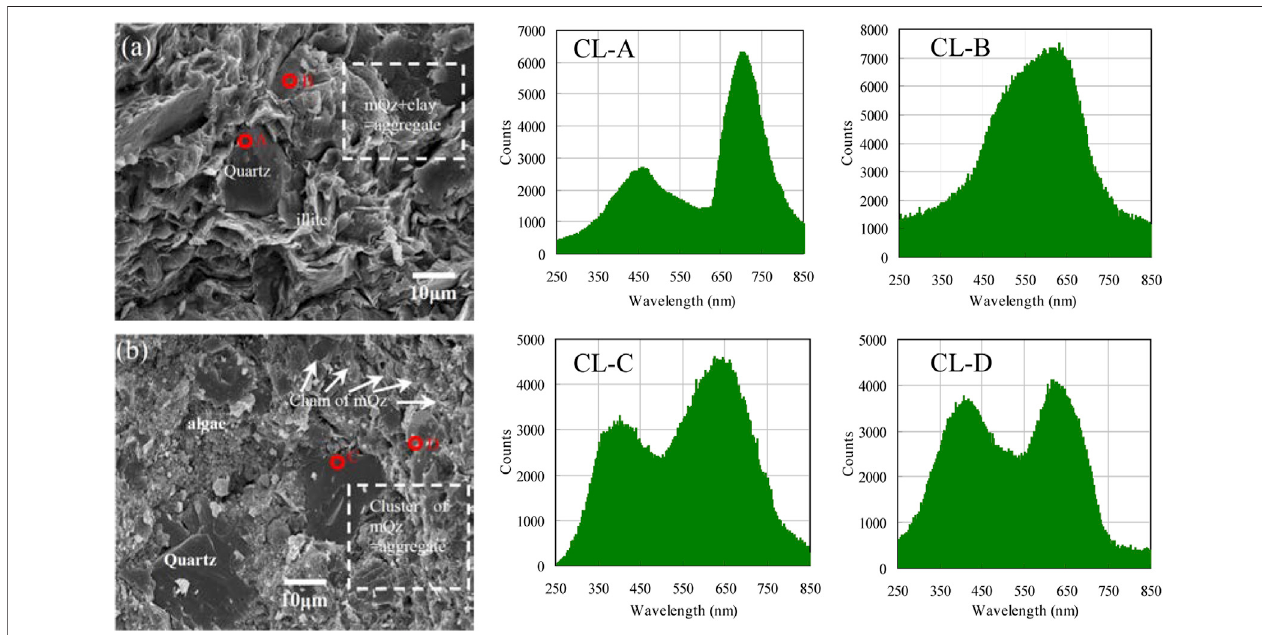
FIGURE 12 | Typical characteristics of quartz in shale samples. (A) SEM photomicrographs of shale sample C8 from the upper part of the Wufeng-Longmaxi Formationshale(mQz:microcrystallinequartz).Discretemicrocrystallinequartzembeddedinthe fi ne-grainedillitizedsmectiticclaymatrix. (B) SEMphotomicrographsof shale sample C39 from the lower part of the Wufeng-Longmaxi Formation shale. Microcrystalline quartz formed coalescent aggregates. CL-A corresponding CL spectrumofextrabasinalquartz.CL-BcorrespondingCL spectrum ofauthigenic quartzsourced from smectite toillitereaction.CL-C and CL-D corresponding CL spectrum of biogenic